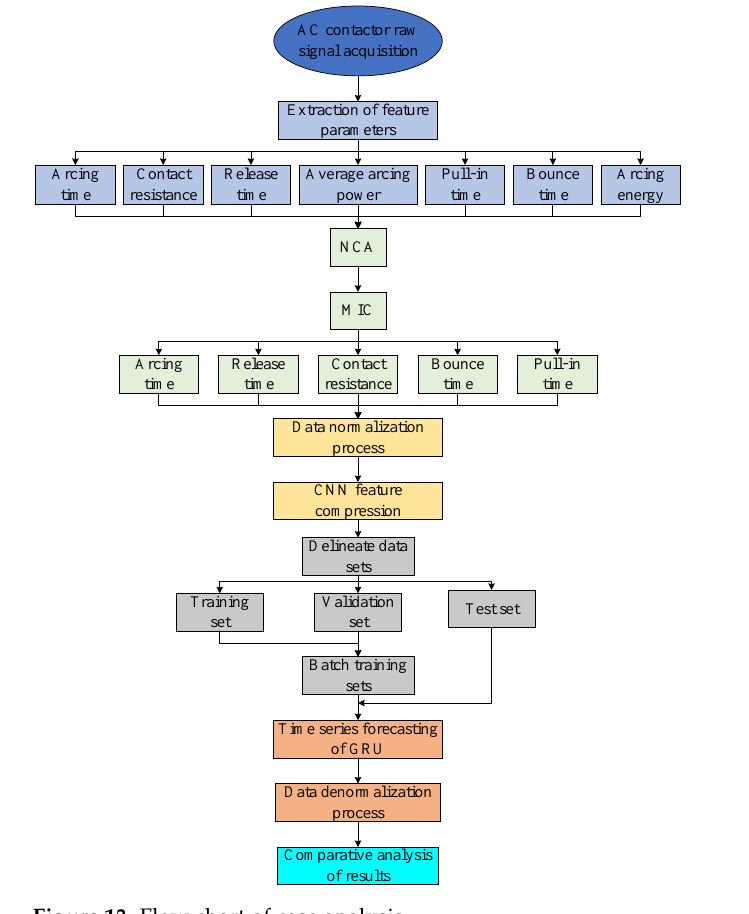
Figure 13. Flow chart of case analysis.